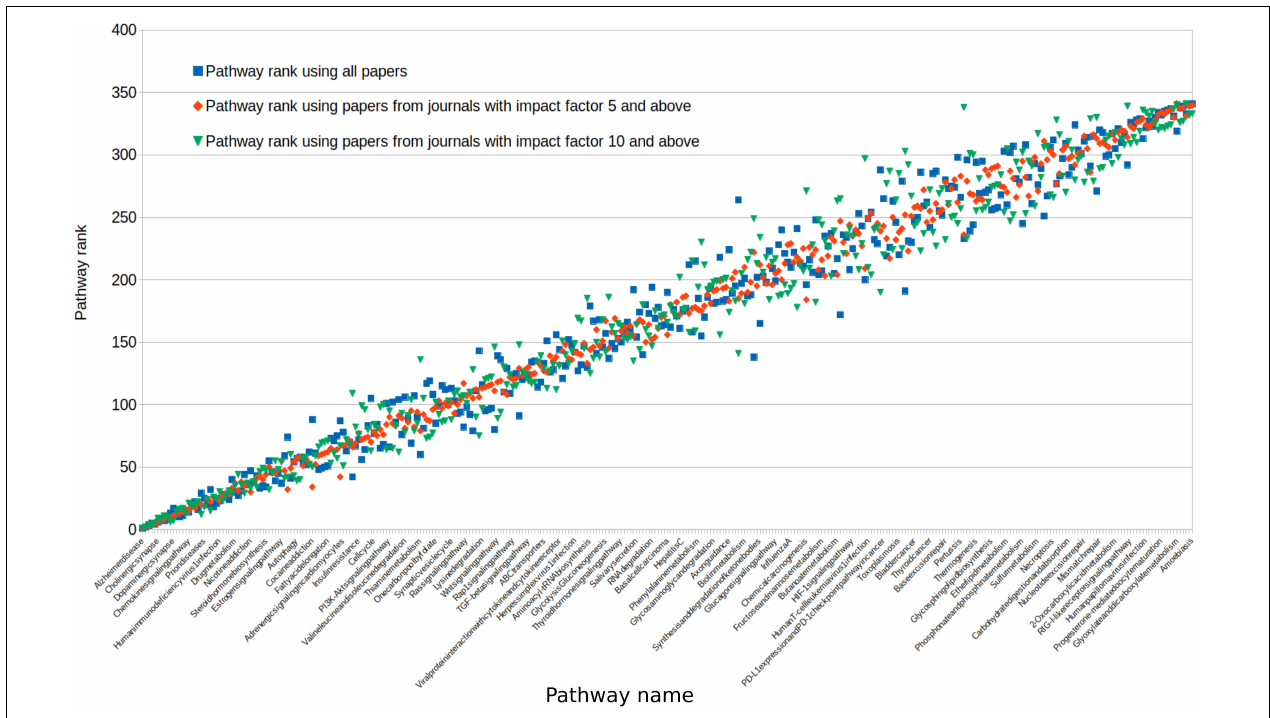
FIGURE 5 | We reassessed all pathway ranks after selecting journal sources with a differing impact. Impact of greater than 5 (red) or greater than 10 (green) comparing this to all studies from any journal (blue). For clarity, pathways on this figure were ordered by the average rank across these three groups. Because of this, the variability in impact > 5 (red) falsely appears to be less, as it is a halfway point between the other two scores.